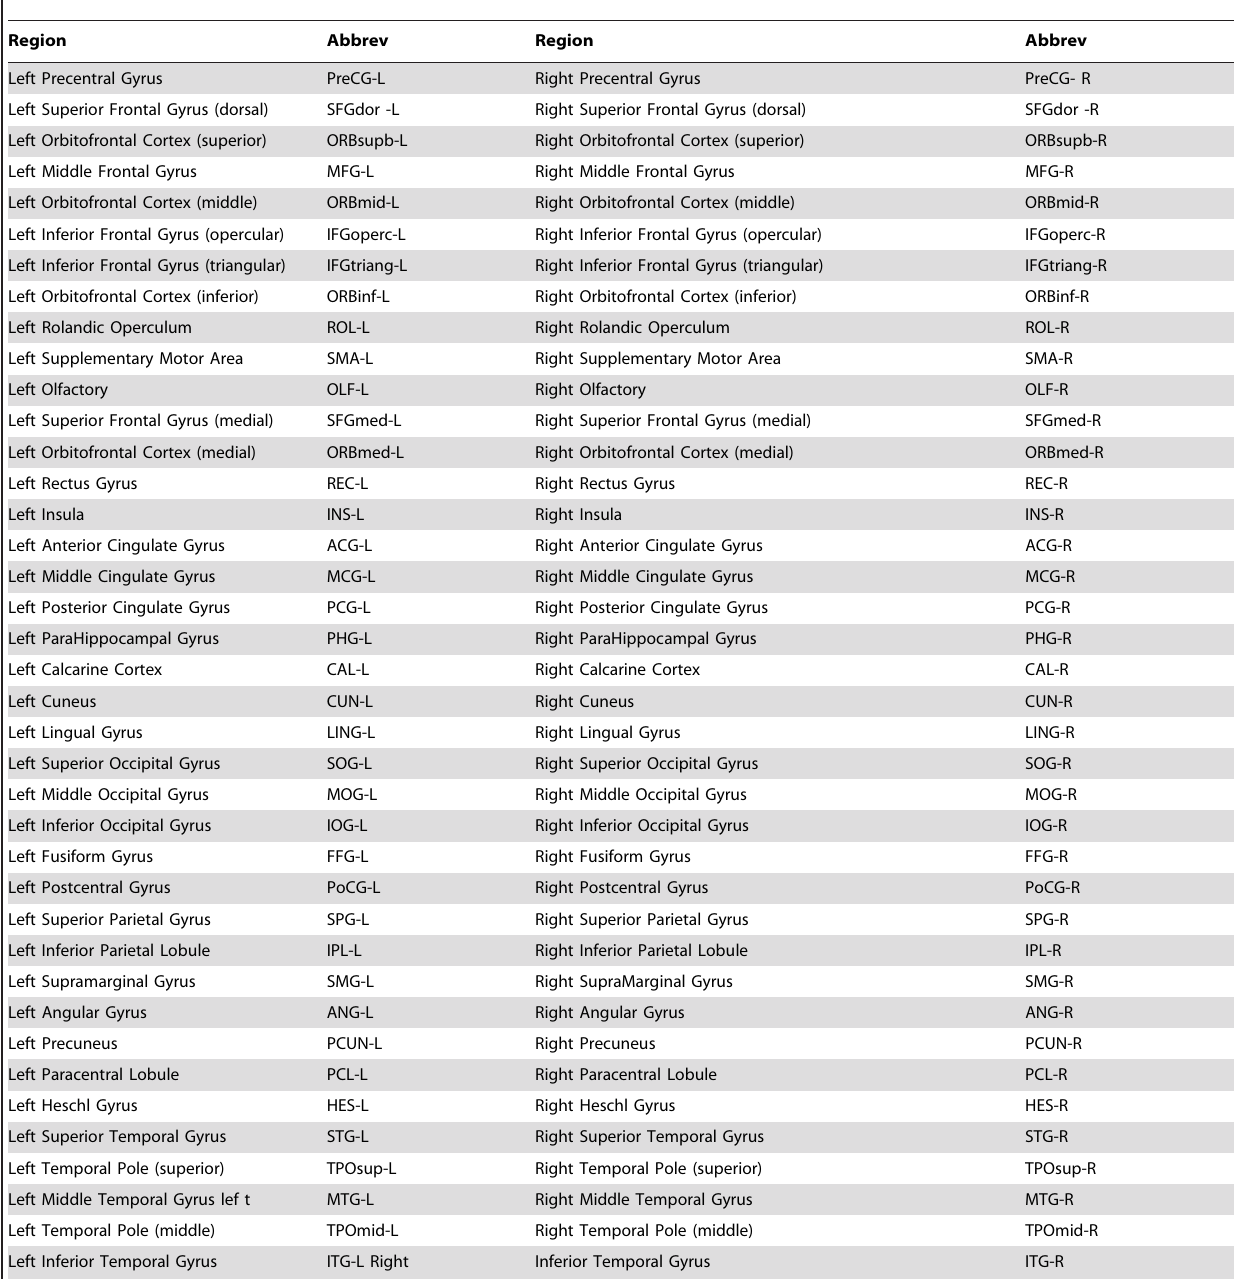
Table 1. Regions of Interest Based on the Automated Anatomical Labeling (AAL) Template.